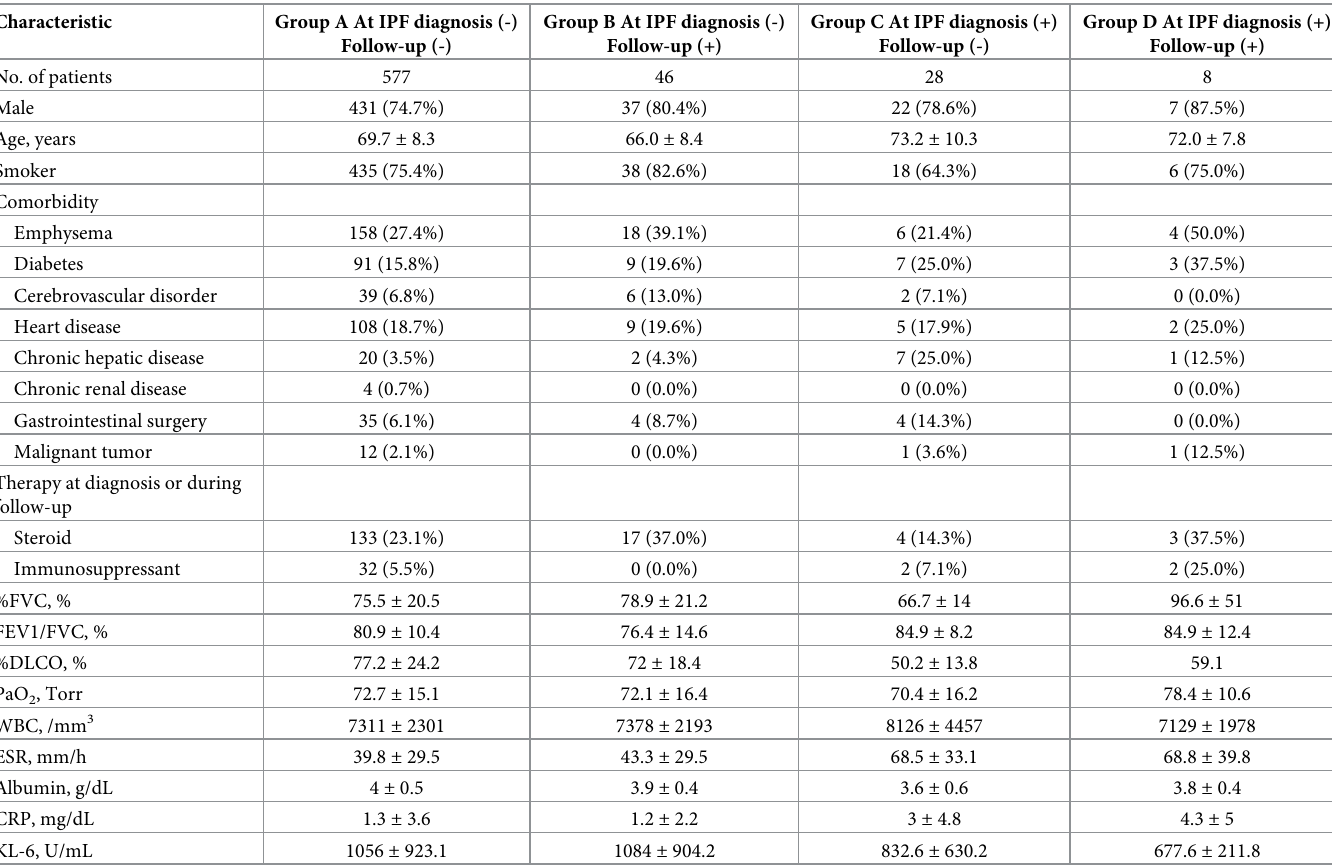
Table 1. Baseline characteristics of the study patients with IPF according to presence or absence of chronic pulmonary infections at diagnosis or during follow-up.